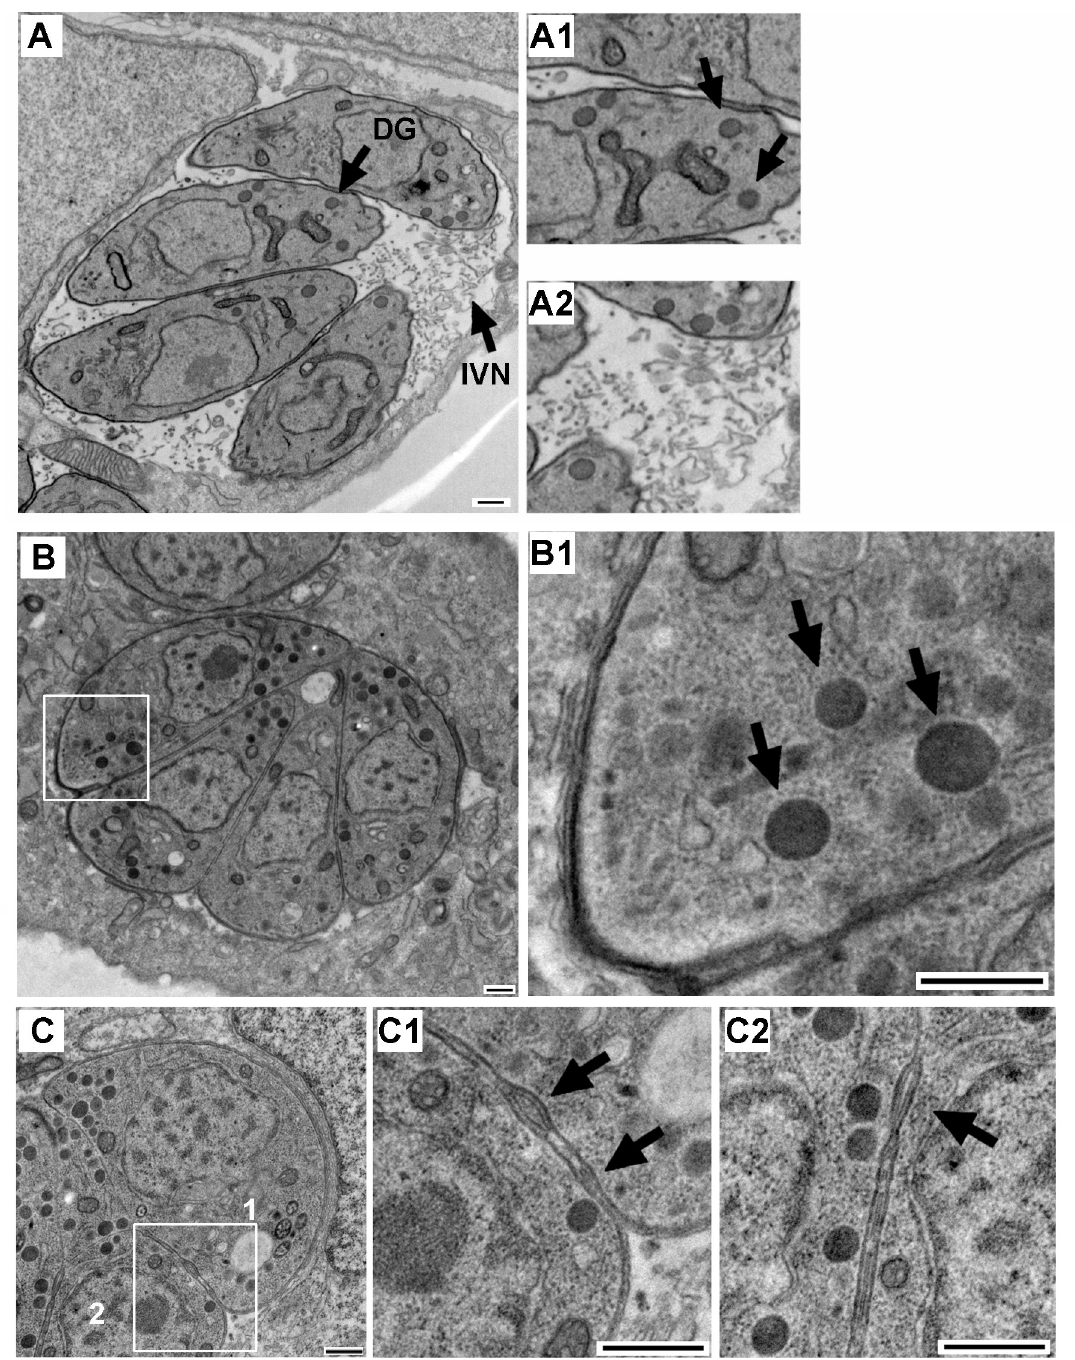
Fig 4. Electron micrographs of infected host cells harboring Shield-1 induced Rab11A-WT replicating parasites ( A ), in which dense granules (A1) and the IVN (A2) are visualized. Shield-1 induced Rab11A-DN parasites ( B-C ) accumulate dense granules (B and B1: a zoom of the region indicated by a white frame in B) and the IVN is not detected in the drastically reduced vacuolar space (B). Rab11A-DN expressing parasites also display a previously described defect in membrane segregation between daughter cells ( C ). A zoom of the regions 1 and 2 is shown in C1 and C2. Bars: